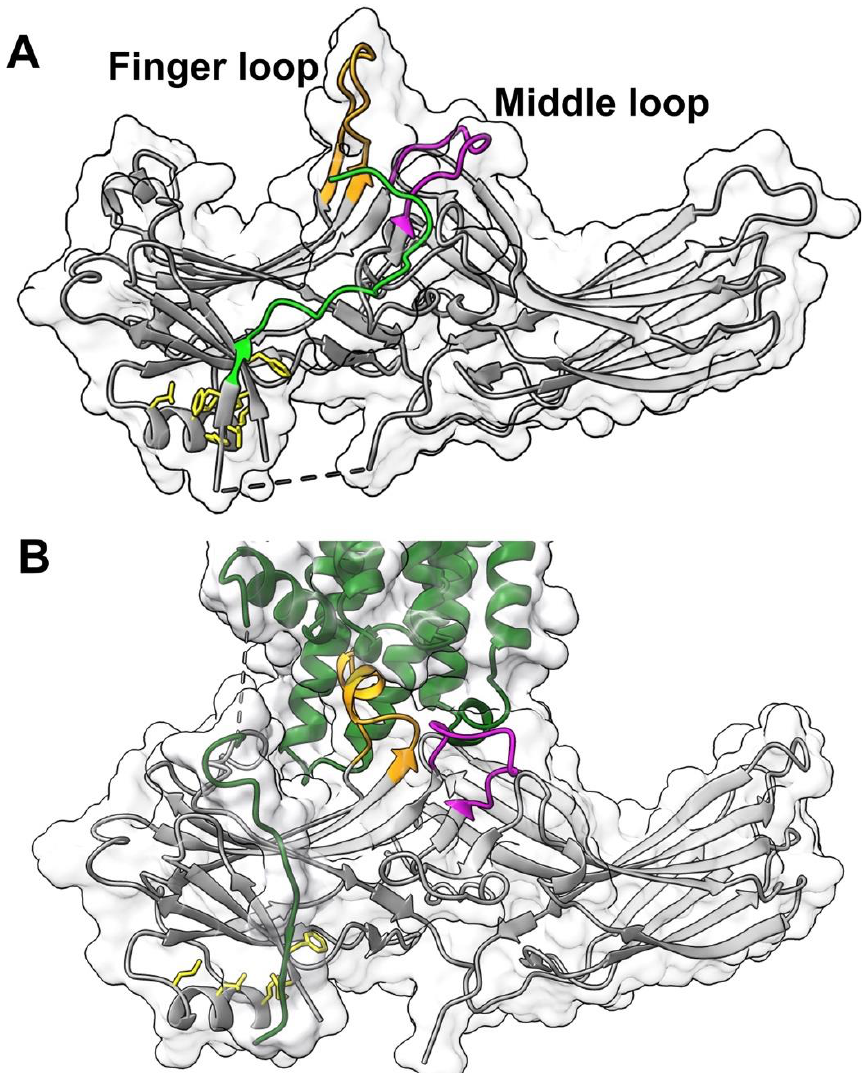
Figure 1. The position of the middle loop in free and rhodopsin-bound arrestin-1. ( A ) Arrestin-1 (molecule A in the crystal tetramer of bovine arrestin-1, PDB ID: 1cf1 [8]) with finger loop (residues 68 – 81) shown in orange and middle loop (residues 132 – 142) in magenta. Attached arrestin-1 C-ter- minus is shown in bright green. ( B ) The structure of the mouse arrestin-1 complex with rhodopsin (complex A, PDB ID: 5w0p [15]). Arrestin-1 (gray) in all panels and rhodopsin (dark green) in panel ( B ) are shown as flat ribbons with molecular surfaces indicated. The direction (N-to- C) of β -strands is shown by arrows. Side chains of bulky hydrophobic residues mediating the three-element inter- action [8] are shown as yellow stick models. Images were created in DS ViewerPro 6.0 (Dassault Systèmes, San Diego, CA, USA).